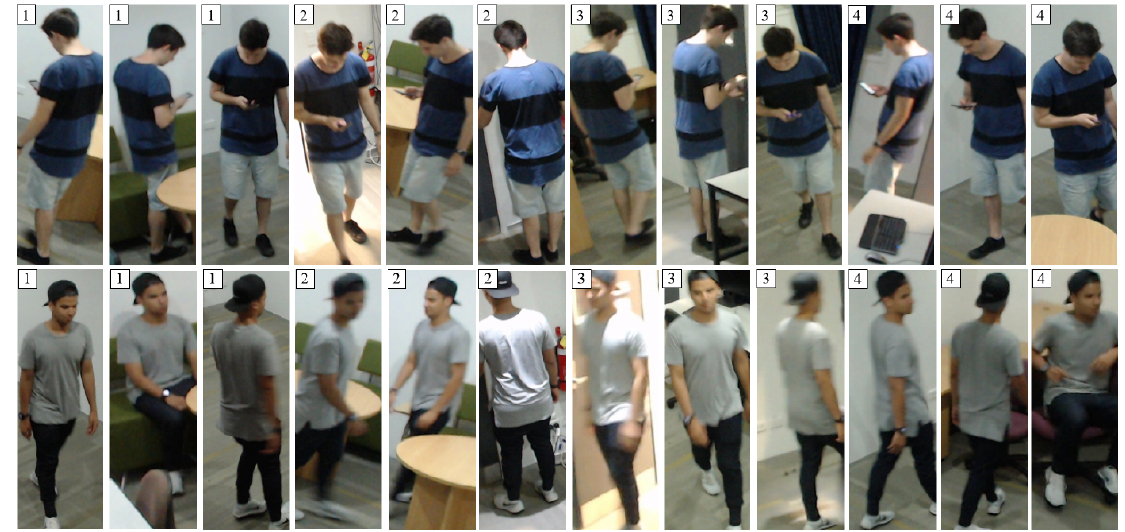
Figure 1. Samples from the UoA-Indoor re-identification dataset extracted with DPM for two classes, with the camera view number shown in the top